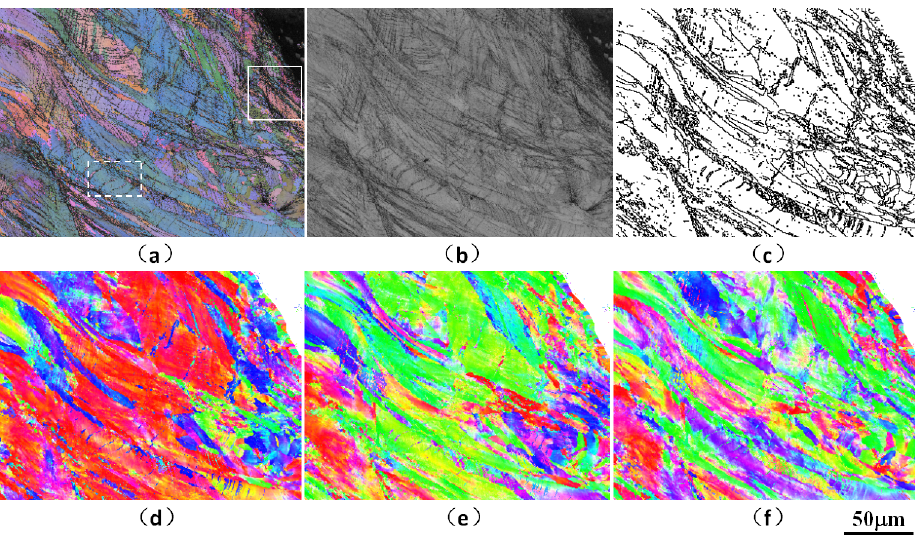
Figure 16. EBSD analysis results of microstructure near the fracture surface of the fatigue failure specimen of the SLM HEA: ( a ) comparison of all Euler diagrams and diffraction bands, ( b ) diffraction band comparison chart, ( c ) large angle (>15° black line) grain boundary diagram, ( d ) IPF_X inverse pole figure, ( e ) IPF_Y inverse pole figure, ( f ) IPF_Z inverse pole figure.